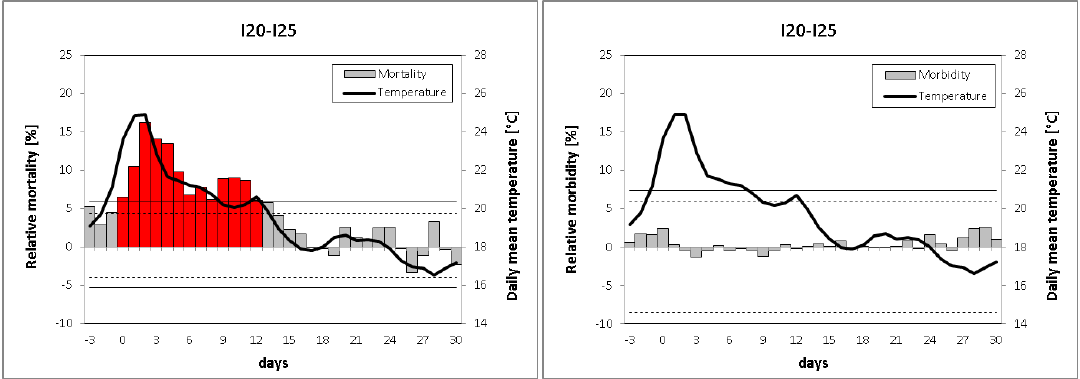
Table 4. Heat wave effects on IHD mortality: ( a ) Based on all heat waves during 2001–2010. Differences between individual genders (male vs. female) and IHD subtypes (I20–I22 vs. I24–I25) are significant (α < 0.05); ( b ) According to heat wave intensity classes (lower, medium, and upper tercile of daily mean temperature distribution during heat